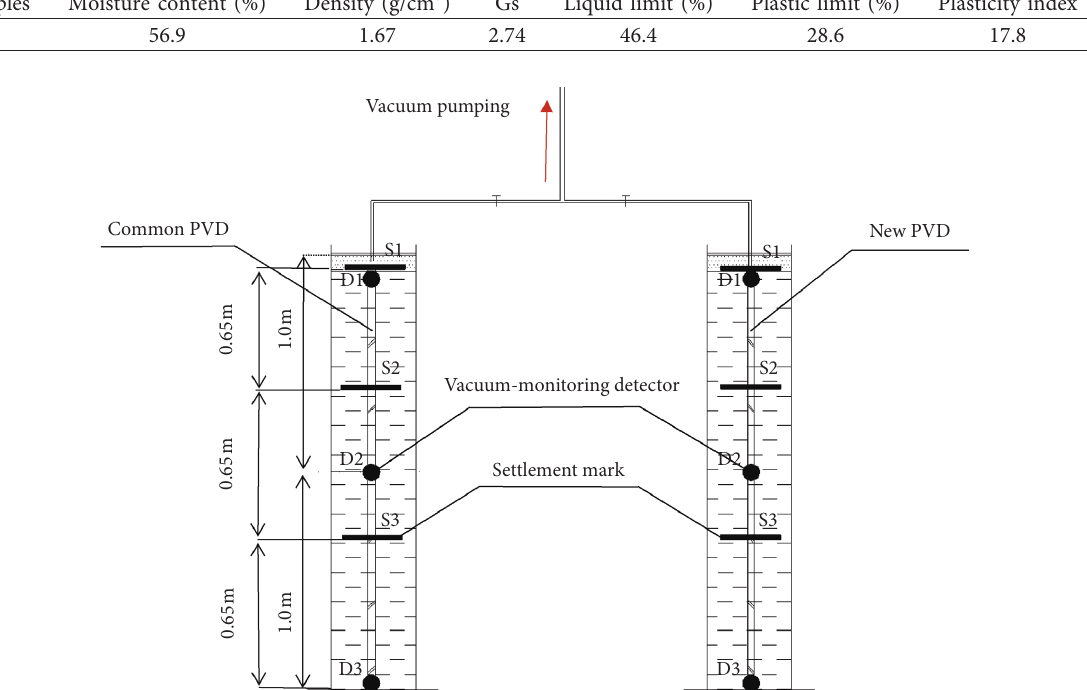
Figure 5: The model-testing device (applying the common PVD on the left and new PVD on the right).